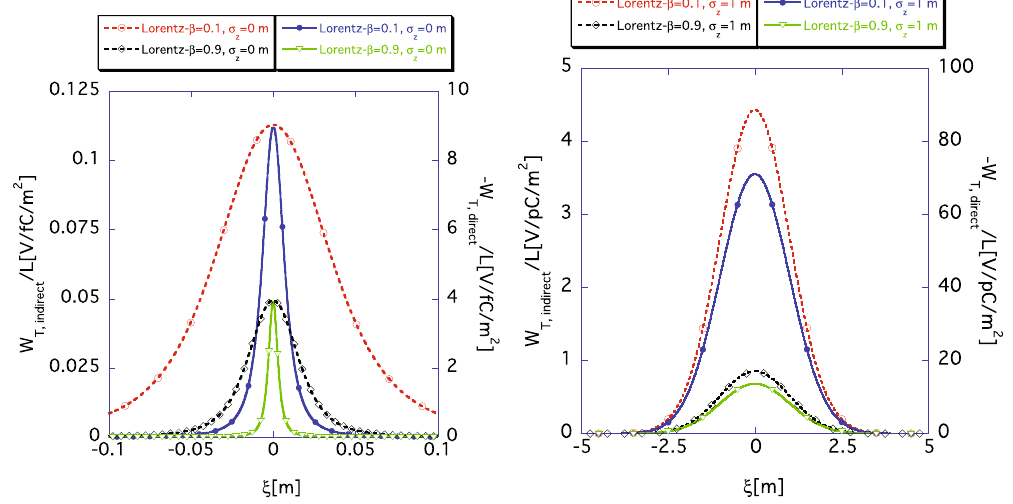
Figure 6. The rms size bunch length σ z dependence of indirect (dashed) W T , indirect ( ξ ) according to Eq. (25) and the direct (solid) wake functions W T , direct ( ξ ) according to Eq. (24), where r b = 10 mm and a = 40 mm. The dashed ( W T , indirect ( ξ )) and solid ( W T , direct ( ξ )) lines are read using the scale markings on the left and the right vertical axes, respectively. The left and the right panels show the wake functions for σ z = 0 m and 1 m, respectively. The purple and red lines show the wake functions for β = 0.1 and the green and black lines for β =